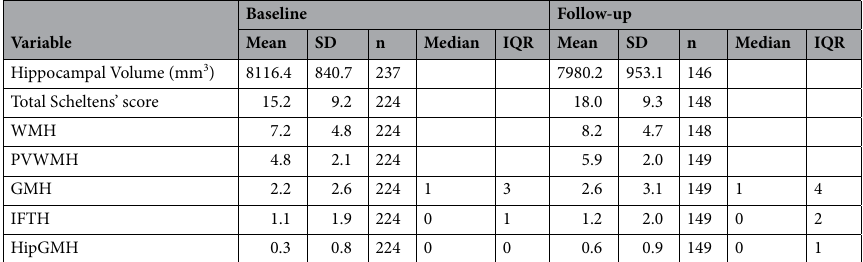
Table 2. Summary statistics for participant hippocampal volume (HipV—mm 3 ), total Scheltens’ score, number of deep white matter hyperintensities (WMH), number of periventricular white matter hyperintensities (PVWMH), number of grey matter hyperintensities (GMH), number of infratentorial hyperintensities (IFTH) and number of hippocampal grey matter intensities (HipGMH) at the time of MRI image collection. Only individuals with information on sex, total intracranial volume and age are included. Medians and interquartile ranges (IQRs) are additionally reported for variables with non-normal distributions.